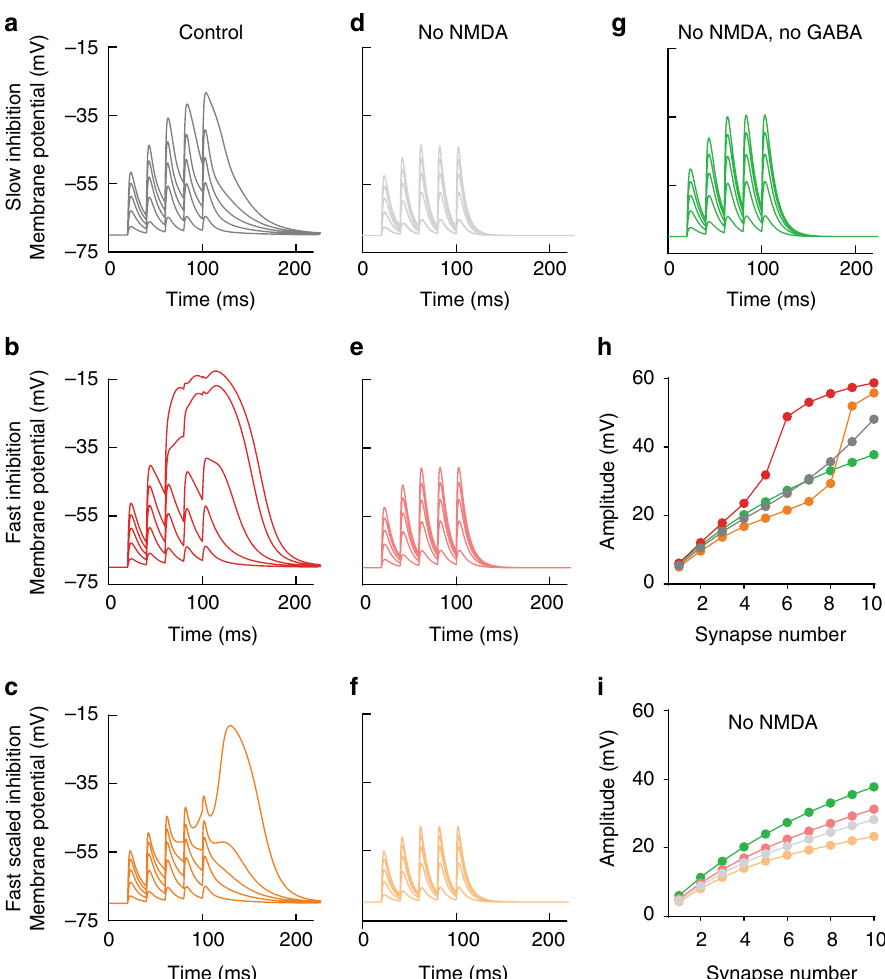
Fig. 7 Slow kinetics of outward-rectifying GABARs allow for effective inhibition of NMDAR-mediated electrogenesis. a Family of voltage traces of burst activation of an increasing number of glutamatergic inputs (1, 3, 5, 7, and 9; 0.14 nS each) in the presence of one nonlinear SOM-like GABAergic model synapse with slow kinetics. b Responses to the same stimulation when the nonlinear GABAergic model synapse has fi ve-times faster kinetics (rise τ = 0.2 ms; decay τ = 6 ms) similar to PV-basket-cell-mediated perisomatic inhibition. c The amplitude of the conductance was additionally scaled by a factor of 5 (from 0.7 to 3.5 nS) to compensate for the decreased inhibitory charge when kinetics are faster. Note that despite the same total integral conductance, fast scaled inhibition was less effective at preventing NMDAR-mediated dendritic spikes. d – f The same simulations when only AMPARs were present in glutamate synapses. Note the larger effect of fast scaled inhibition onto AMPAR-mediated depolarization. g Pure AMPAR responses without any inhibition. h The dependence of the peak burst amplitude on glutamatergic input number. Note the strongly nonlinear behavior for both forms of fast inhibition. i Dependence of the peak burst amplitude on input number when only AMPARs were present in the glutamate